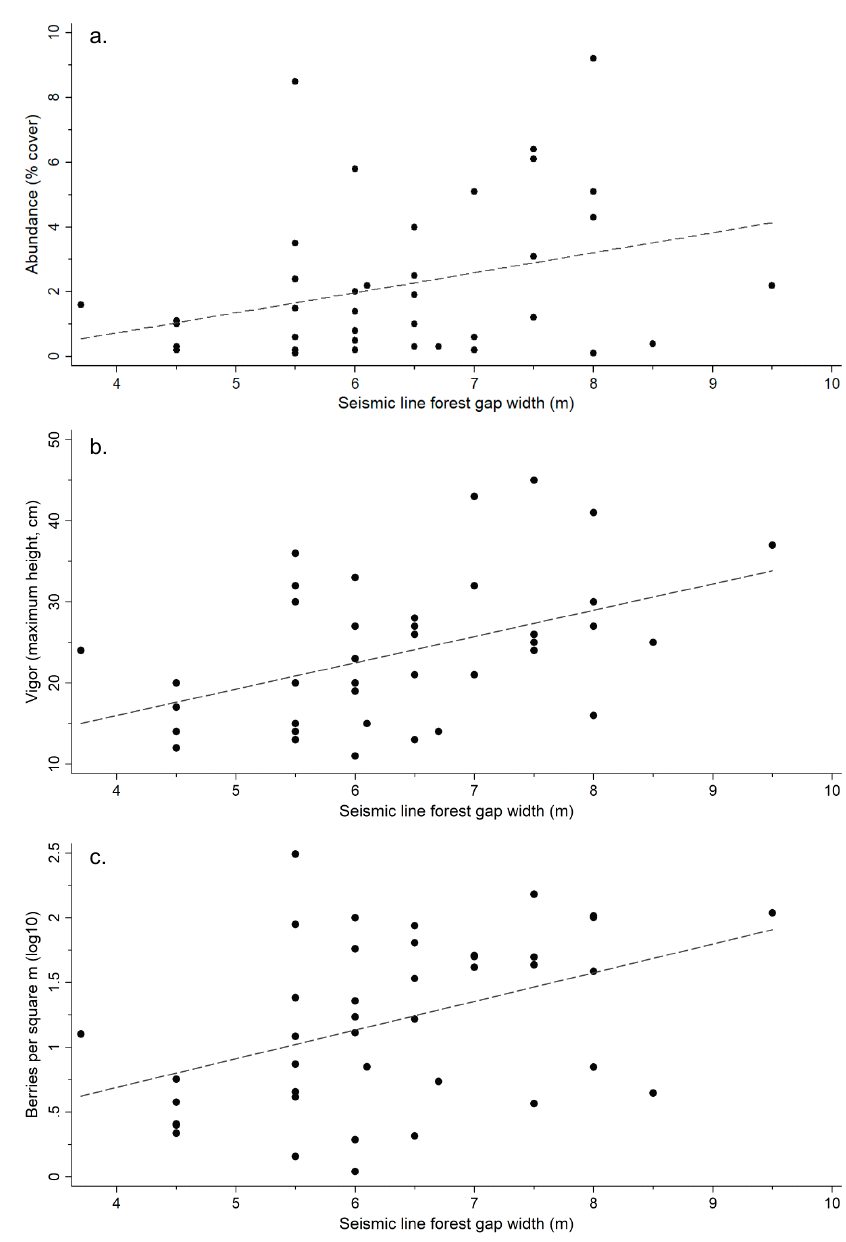
Figure 6. Scatterplot of seismic line width and Vaccinium myrtilloides cover ( a ), vigor ( b ), and berry production ( c ) on seismic lines where plants were present. Dashed line represents the fit of a linear regression relationship with overall model fit as follows: abundance (cover) R 2 = 0.12 ( a ), vigor (height) R 2 = 0.19 ( b ), and berry production R 2 = 0.16 ( c ).